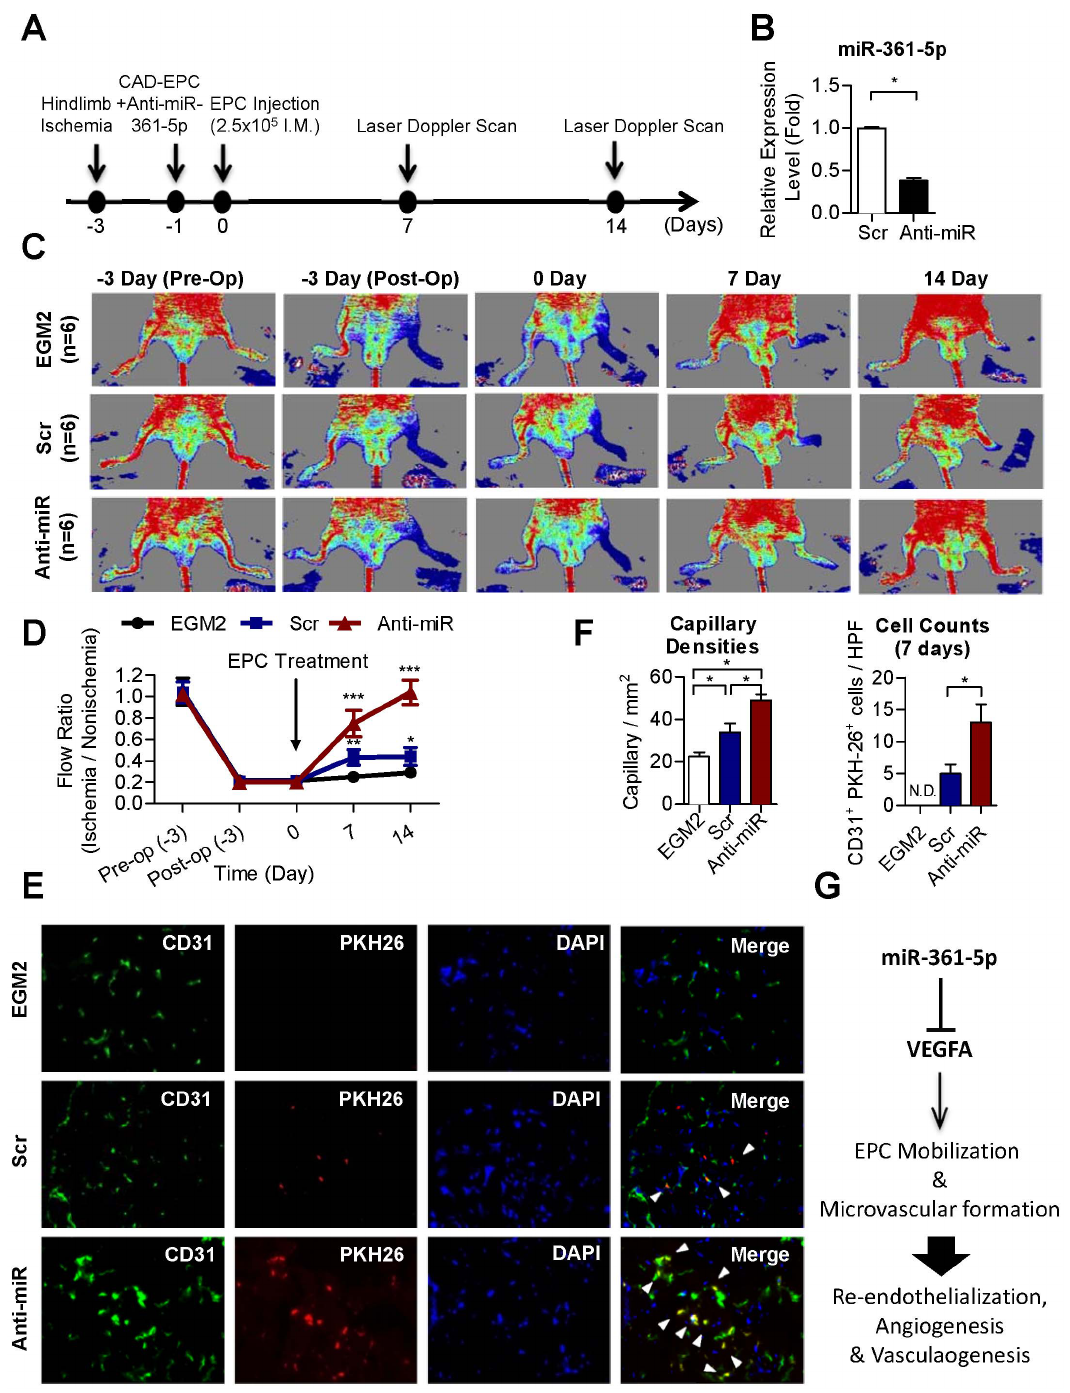
Figure 5. Transplantation of miR-361-5p low CAD-EPCs improves blood perfusion in the ischemic hindlimb. ( A ) Schematic represeatation of experimental design. ( B ) miR-361-5p levels in tranfected CAD-EPCs determined by RT-qPCR. *: p , 0.05 by Student’s T test. ( C ) Representative images of hindlimb blood flow measured by laser Doppler before operation (Pre-Op), immediately after hindlimb ischemia surgery (Post-Op), and 2 weeks after intramuscular injection of culture medium (EGM2), peripheral blood EPC-transfected with scramble oligonucleotides (Scr), or CAD-EPC-transfected with miR-361-5p oligonucleotide antagomirs (Anti-miR). ( D ) Quantitative analysis of blood flow expressed as perfusion ratio of the ischemic to the contralateral (non-operated) hindlimb. *: p , 0.05; **: p , 0.01: ***: p , 0.001 compared with control; n=6. ( E ) Immunofluorescence staining on nude mice tissues 7 days after injection with PKH-26-labeled CAD-EPCs. Capillaries in the ischemic muscles were visualized by anti-CD31 immunostaining (green), and injected human EPCs were monitored by PKH-26 fluorescence (red). Mice receiving miR-361-5p- repressed EPCs had more CD31 + /PKH-26 + double-positive cells (white arrowheads) in ischemic muscle than another 2 control mice groups (Scr and medium). DAPI: nuclear staining of live cells (blue). ( F ) Quantitative analysis of capillary densities and CD31 + /PKH-26 + double-positive cells in ischemic muscle of mice hindlimb ischemia surgery. HPF: high power field; N.D.: not detectable; *: p , 0.05 by one-way ANOVA test followed by Tukey’s post-hoc test. ( G ) A proposed model of EPC angiogenesis activities are regulated by the miR-361-5p-VEGF pathway. doi:10.1371/journal.pone.0098070.g005 PLOS ONE |